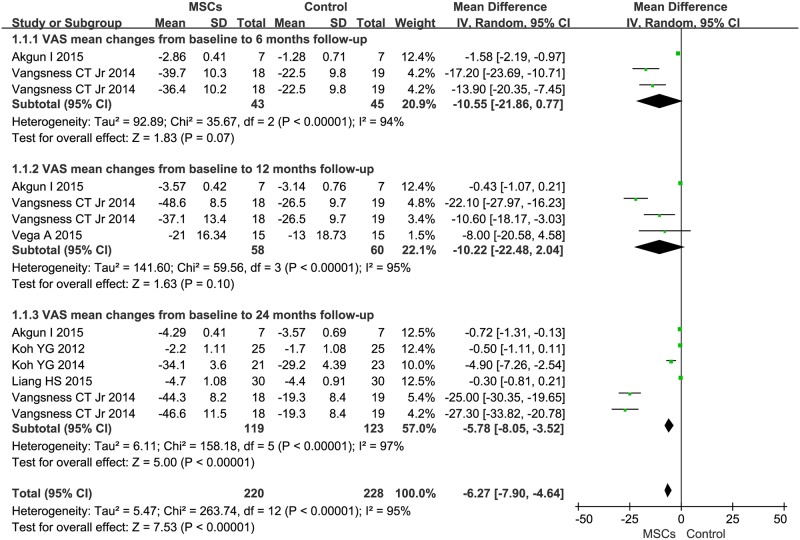
Forest plots of mean difference (MD) with 95% confidence interval (CI) in VAS between patients undergoing MSC therapy and controls at: (1) 6 months, (2) 12 months, and (3) 24 months.Random-effects models (Mantel-Haenszel method) were used. Each trial is represented by a square, and the size of the square is proportional to the information in that trial. The ends of the horizontal bars denote 95% confidence intervals (CIs). Black diamonds give the overall results of all trials.